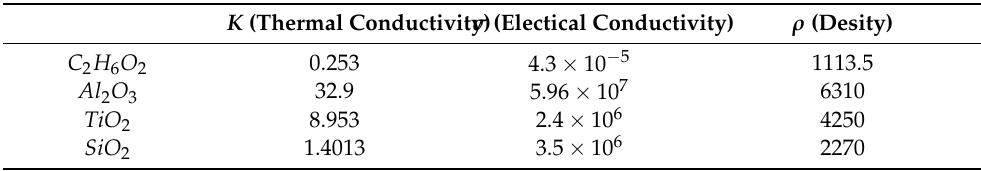
Table 1. Thermal properties [32] of Al 2 O 3 , TiO 2 , C 2 H 6 O 2 and SiO 2 . K (Thermal Conductivity) σ (Electical